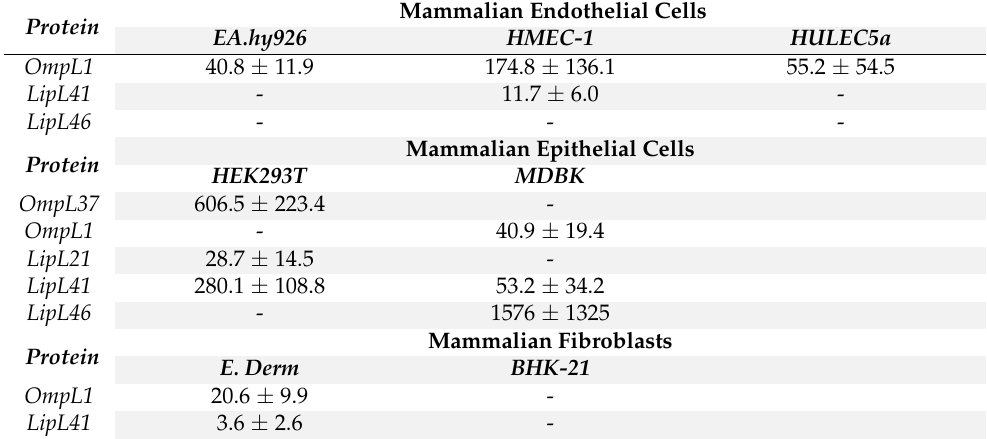
Table 1. Dissociation constants (K D ) represented in nM from protein binding to immobilized mammalian